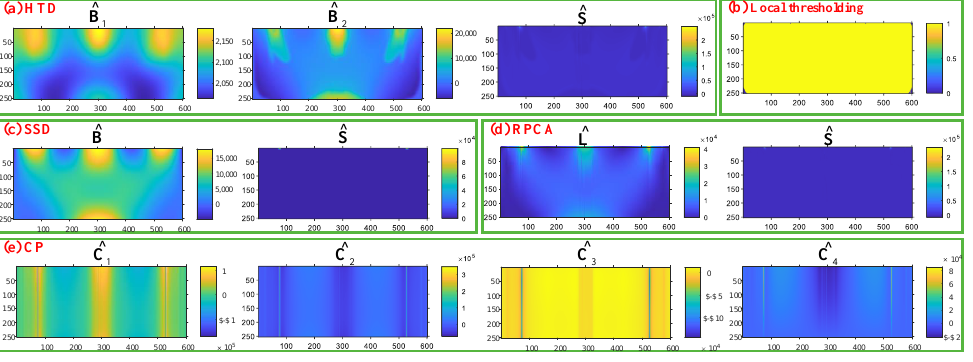
Figure 10. Results of the case study using the proposed method and benchmark methods. According to Equation (3), the elements that belong to sparse spots in ˆ S are extracted and binarized. A postprocessing method based on Equation (4) is applied in ˆ B 2 to extract the clustered foreground regions. The region to be detected in ˆ B 2 has a higher intensity value than the background. Therefore, the element ( i , j ) satisfies ˆ B n ( i , j ) > f a is considered n as foreground cluster element. v max = 0, h = 1.6. The foreground cluster and sparse stress concentration detection result of HTD, SSD, and RPCA are labeled, after postprocessed ˆ B 2 and ˆ S , as shown in Figure 11. In Figure 11a, the foreground cluster regions are detected and marked as red color, the sparse stress concentrations are labeled as green color. As shown